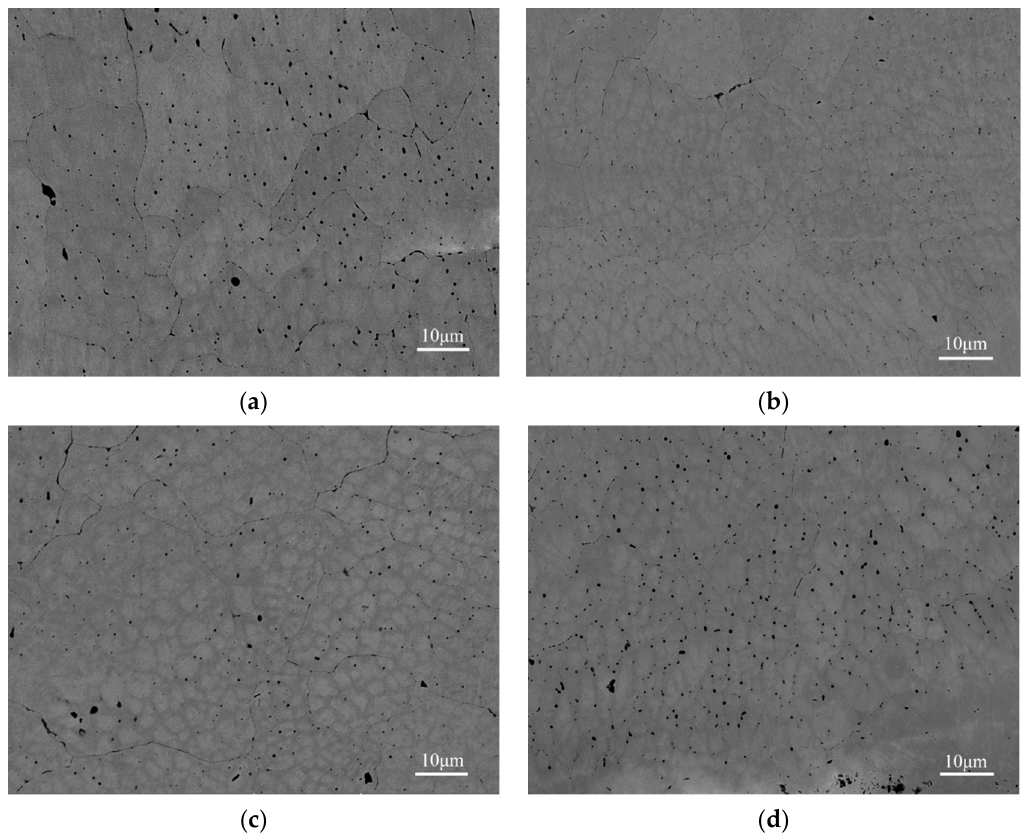
Figure 8. Backscatter electron (BSE) of polished longitudinal-sections of the W x NbMoTa HEAs. ( a ) NbMoTa, ( b ) W 0.16 NbMoTa, ( c ) W 0.33 NbMoTa, ( d ) W 0.53 NbMoTa.